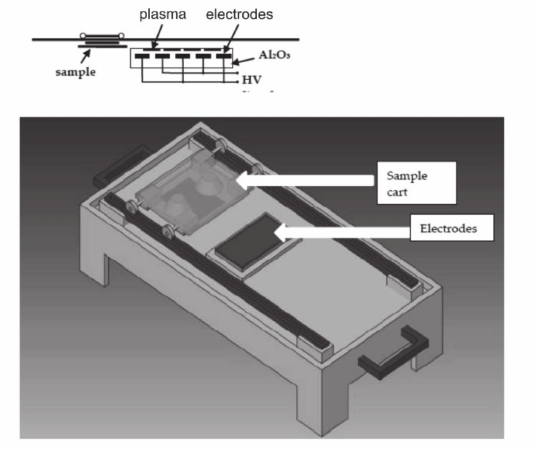
Figure 1. Scheme of DCSBD plasma set